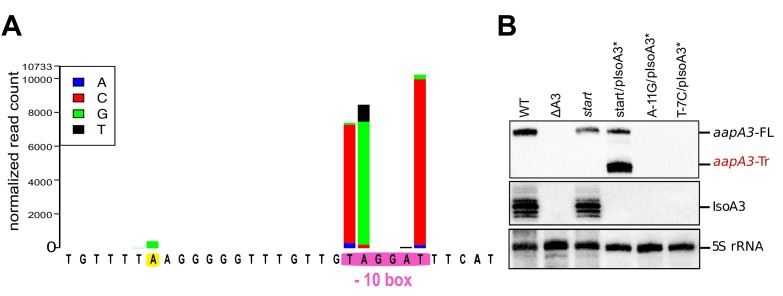
Defining and validating the aapA3 promoter with nucleotide resolution.(A) Statistical analysis of the differential number of individual single-nucleotide substitution sequences in WT (aapA3/IsoA3) and pIsoA3* (aapA3/pIsoA3*) samples was carried out using DESeq2 (‘nucleotide-specific’ analysis; see Materials and methods section for details). Nucleotide substitutions that are significantly enriched (padj ≤0.05) in pIsoA3* compared to WT sequences in aapA3 promoter region are shown. The −10 box of the aapA3 gene promoter is highlighted in pink; an enriched mutation located at position −26 from aapA3 +1 is highlighted in yellow. (B) Total RNA was isolated from the indicated strains and 10 μg were subjected to Northern Blot analysis. The same membrane was successively probed with FD38 labeled oligonucleotide and IsoA3 riboprobe to detect aapA3 and IsoA3 transcripts, respectively. The different transcripts are annotated as: aapA3-FL (full length), aapA3-Tr (3’ end truncated), and IsoA3 full-length and processed transcripts. Proper loading was assessed by the level of 5S rRNA using the labeled oligoprobe FD35.